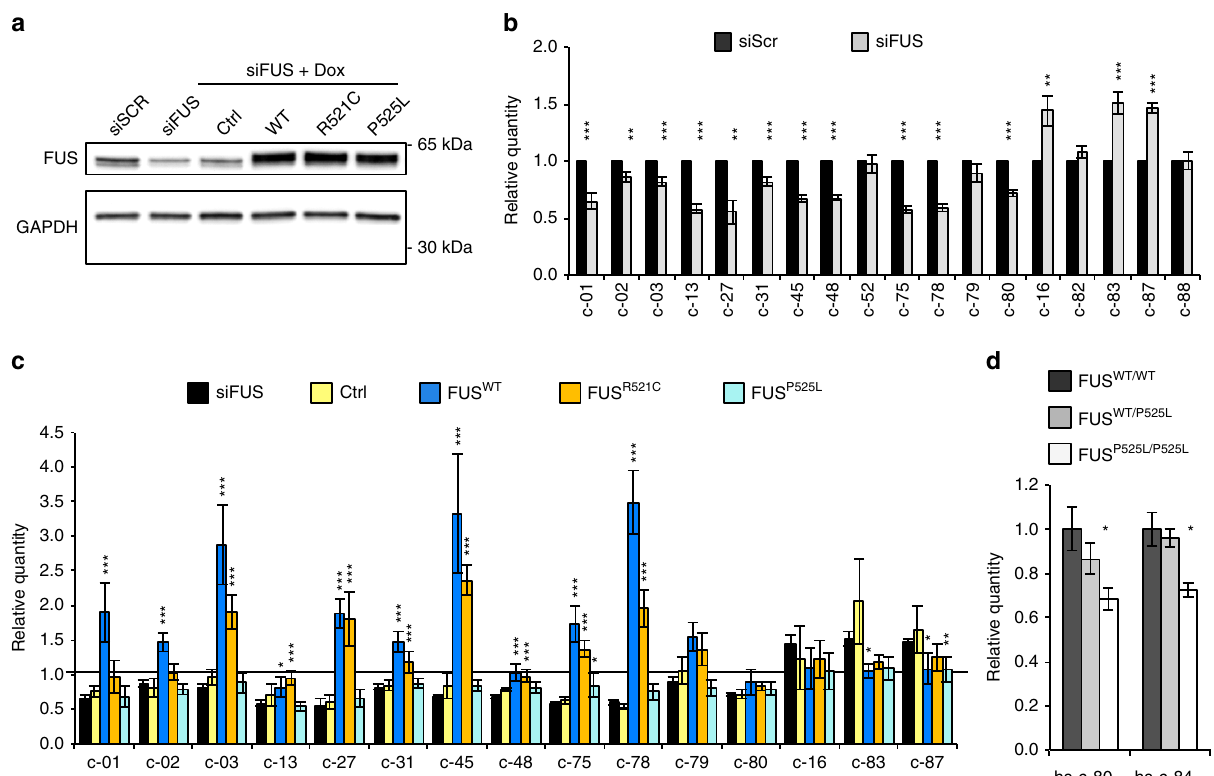
Figure 3 | CircRNA expression upon ectopic expression of wild-type and mutant FUS. ( a ) Western blot analysis on total protein extracts from differentiated N2a cells treated with control siRNAs (siScr) or with siRNAs against FUS (siFUS). In the same blot, shown also are proteins derived from differentiated N2a cells stably transfected with an Ctrl or with FUS WT (WT), FUS R521C (R521C) and FUS P525L (P525L) cDNA expression cassettes and treated with siFUS and Dox. GAPDH was used as a loading control. ( b ) Histograms show the levels of circRNAs in differentiated N2a cells treated with control siRNAs (siScr; black bars) or with siRNAs against FUS (siFUS; grey bars). CircRNA were quantified by qRT–PCR, normalized against Atp5o mRNA levels and expressed as relative quantity with respect to siScr samples set to a value of 1. ( c ) Histograms show the levels of circRNAs in the samples treated as in a ; the values were normalized against Atp5o mRNA levels and siScr samples set to a value of 1. Statistical analysis was performed on Ctrl, FUS WT , FUS R521C and FUS P525L samples against siFUS samples. ( d ) Histograms show the level of hsc-80 and hsc-84 in FUS WT/WT , FUS WT/P525L and FUS P525L/P525L iPSC-derived MNs. CircRNAs were normalized against Atp5o mRNA levels and expressed as relative quantity with respect to FUS WT/WT samples set to a value of 1. For all the experiments shown in the figure, error bars represent s.e.m. of at least three independent